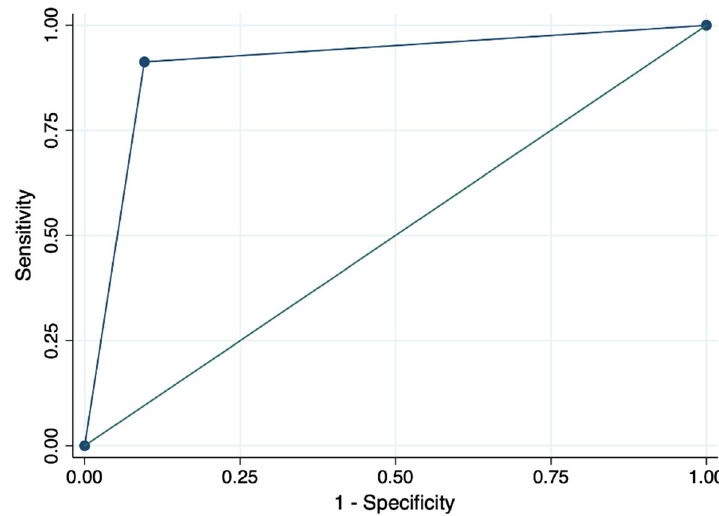
Fig. 7 Healthy lung ROC curve in the test